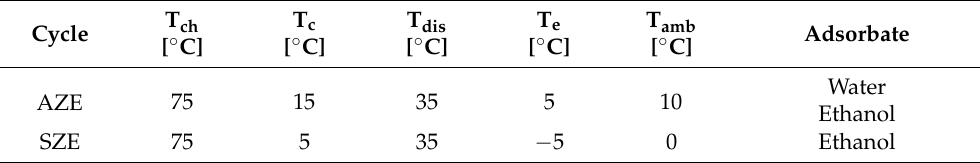
Table 1. The operating and ambient temperature for the investigated heat storage cycles (AZE and